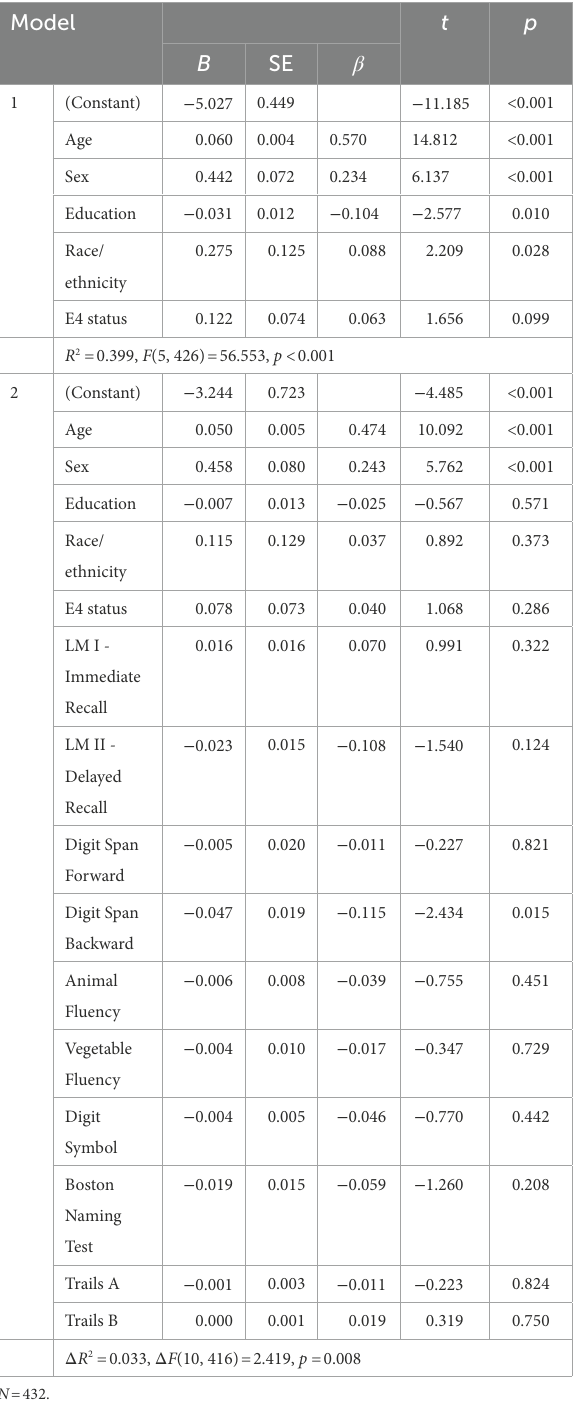
TABLE 3 Hierarchical regression model of cognitive correlates of pathological functioning in cognitively normal group.